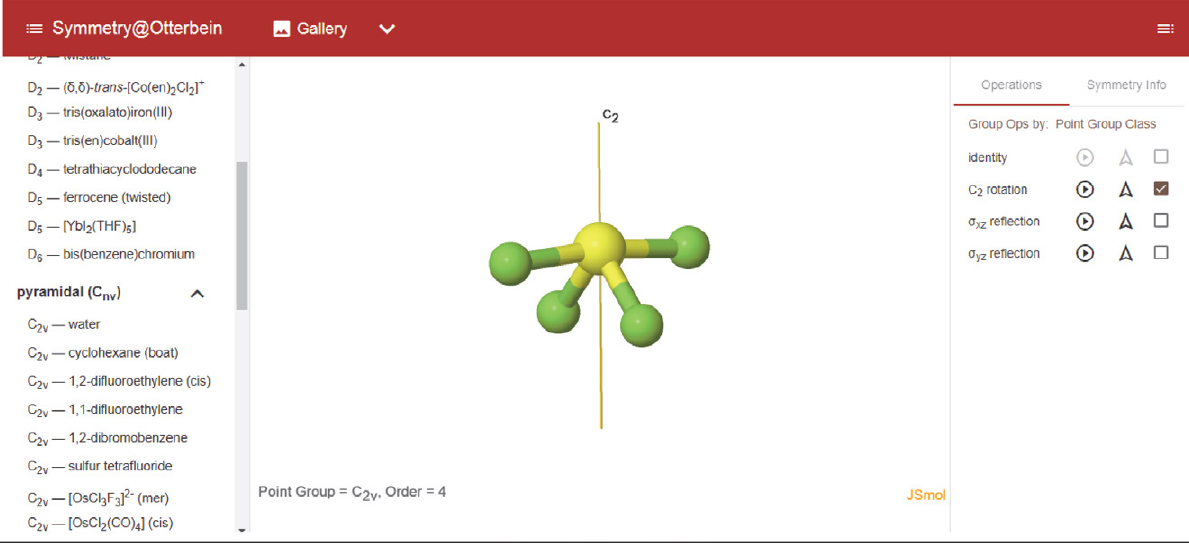
Figure 1. Example of the virtual model presented in the teaching of